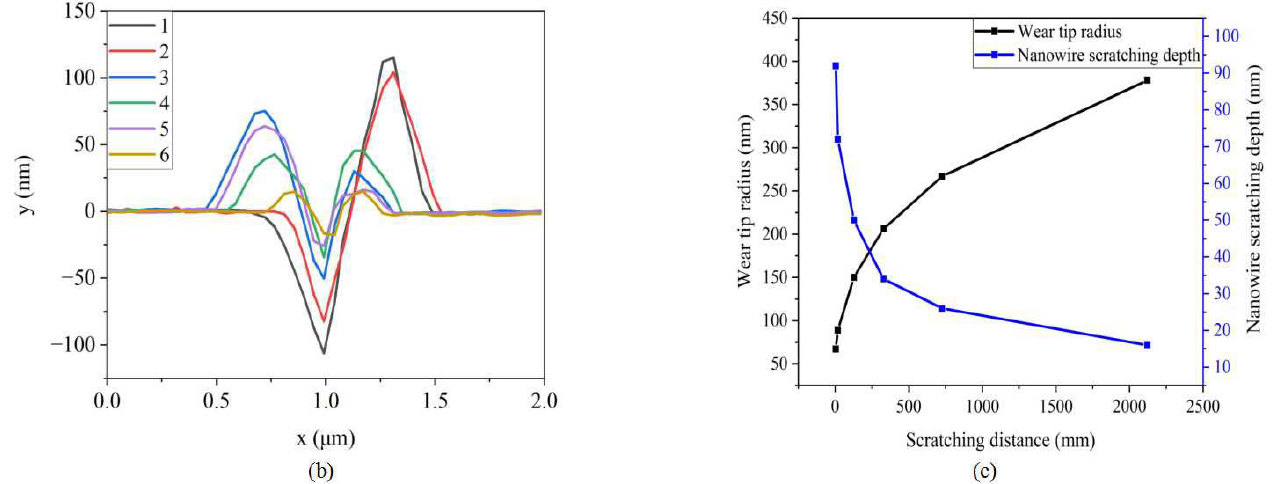
Figure 12. Grooves scratched by six wear probes with different tip radii: ( a ) grooves’ morphology; ( b ) grooves’ cross-section information; ( c ) variation in wear tip radius and depth of grooves with scratching distance .